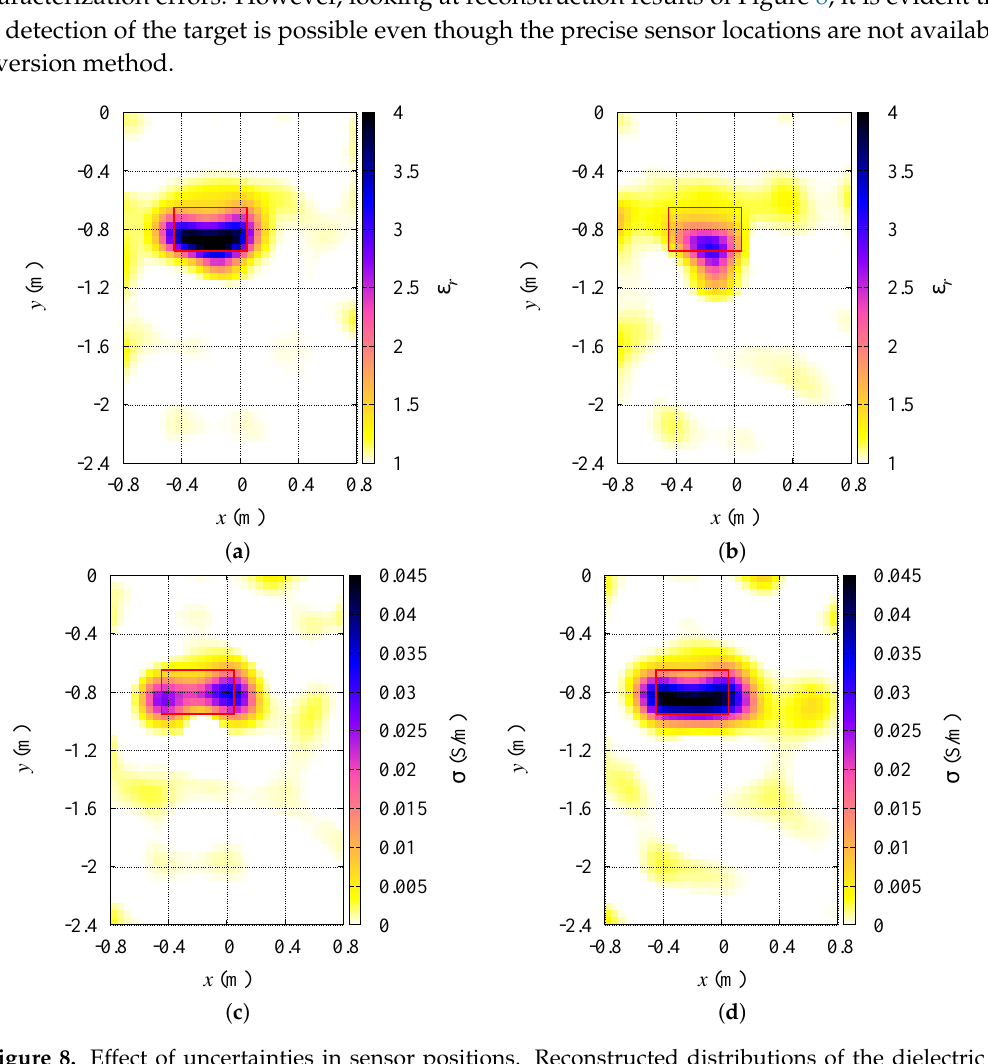
Figure 8. Effect of uncertainties in sensor positions. Reconstructed distributions of the dielectric properties inside the investigation region: ( a ) relative dielectric permittivity, d = 0.025 m; ( b ) relative dielectric permittivity, d = 0.125 m; ( c ) electric conductivity, d = 0.025 m; ( d ) electric conductivity, d = 0.125